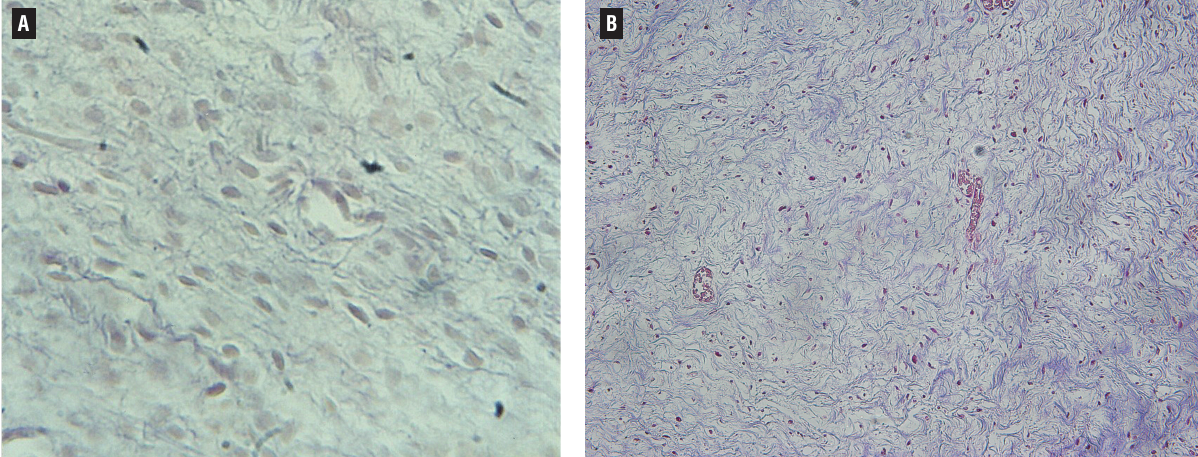
Figure 2 - A) Photomicrograph of a male fetus with 15 weeks post-conception with both testes situated in the abdomen. A low concentration of collagen and elastic fibers in the gubernaculum can be observed (HE, 400x). B) Photomicrograph of a male fetus with 35 weeks post-conception with both testes situated in the scrotum. A condensation of the gubernaculum with a large amount of collagen and elastic fibers can be observed. Masson’s trichrome, 200x. A